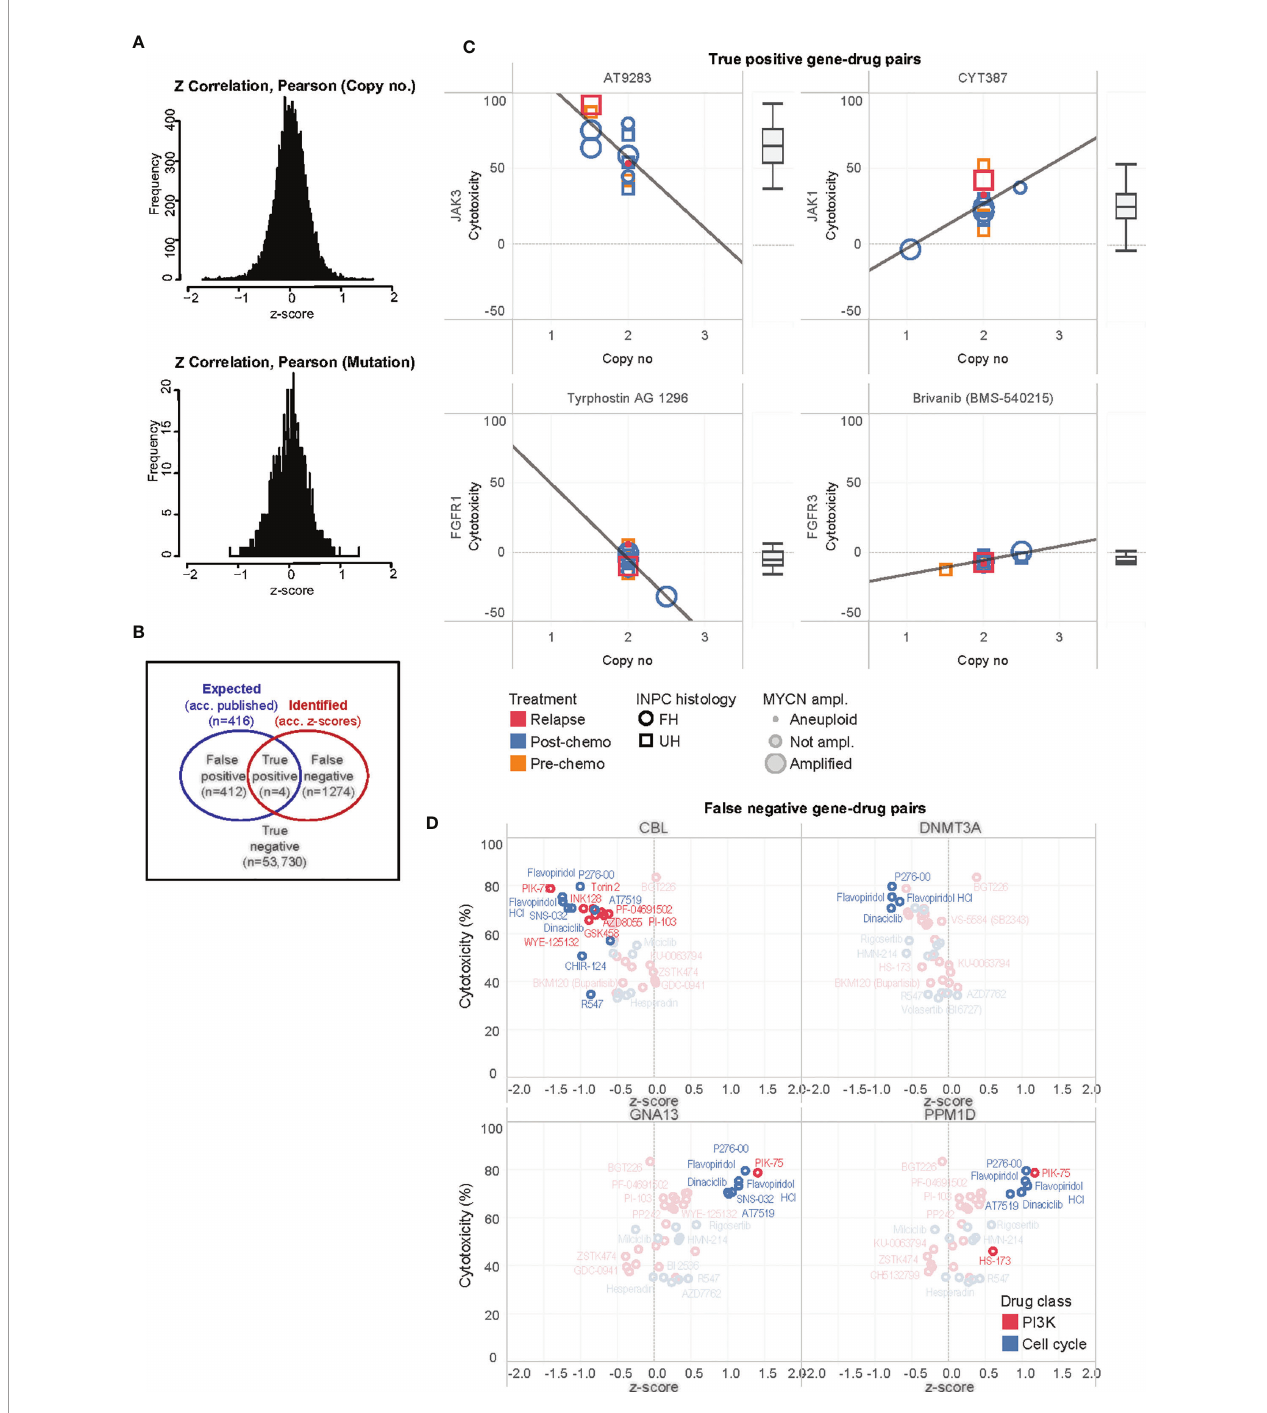
FIGURE 4 | Correlation of signi fi cantly associated gene-drug pairs. (A) Distributions of z-scores of Pearson correlation coef fi cients for correlations of cytotoxicity versus mutational variants and gene copy number among 54,758 gene-drug combinations. (B) Venn diagram illustrating distribution of true positive, false positive, false negative, and true negative gene-drug pairs. (C) Scatterplots of cytotoxicity against copy number for 4 true positive gene-drug pairs across 13 PDC lines, ranked by median cytotoxicity which is represented in the adjacent boxplots. Clinical-pathological characteristics of individual PDC lines are re fl ected in legend. INPC, International Neuroblastoma Pathology Classi fi cation; UH, unfavorable histology; FH, favorable histology. (D) Scatterplots of mean cytotoxicity and z-scores of top- ranked false negative gene-drug pairs of PI3K and cell cycle drugs and CBL, DNMT3A, GNA13 and PPM1D. Gene-drug pairs signi fi cantly correlated at 0.1 FDR are in bold while non-signi fi cant pairs are